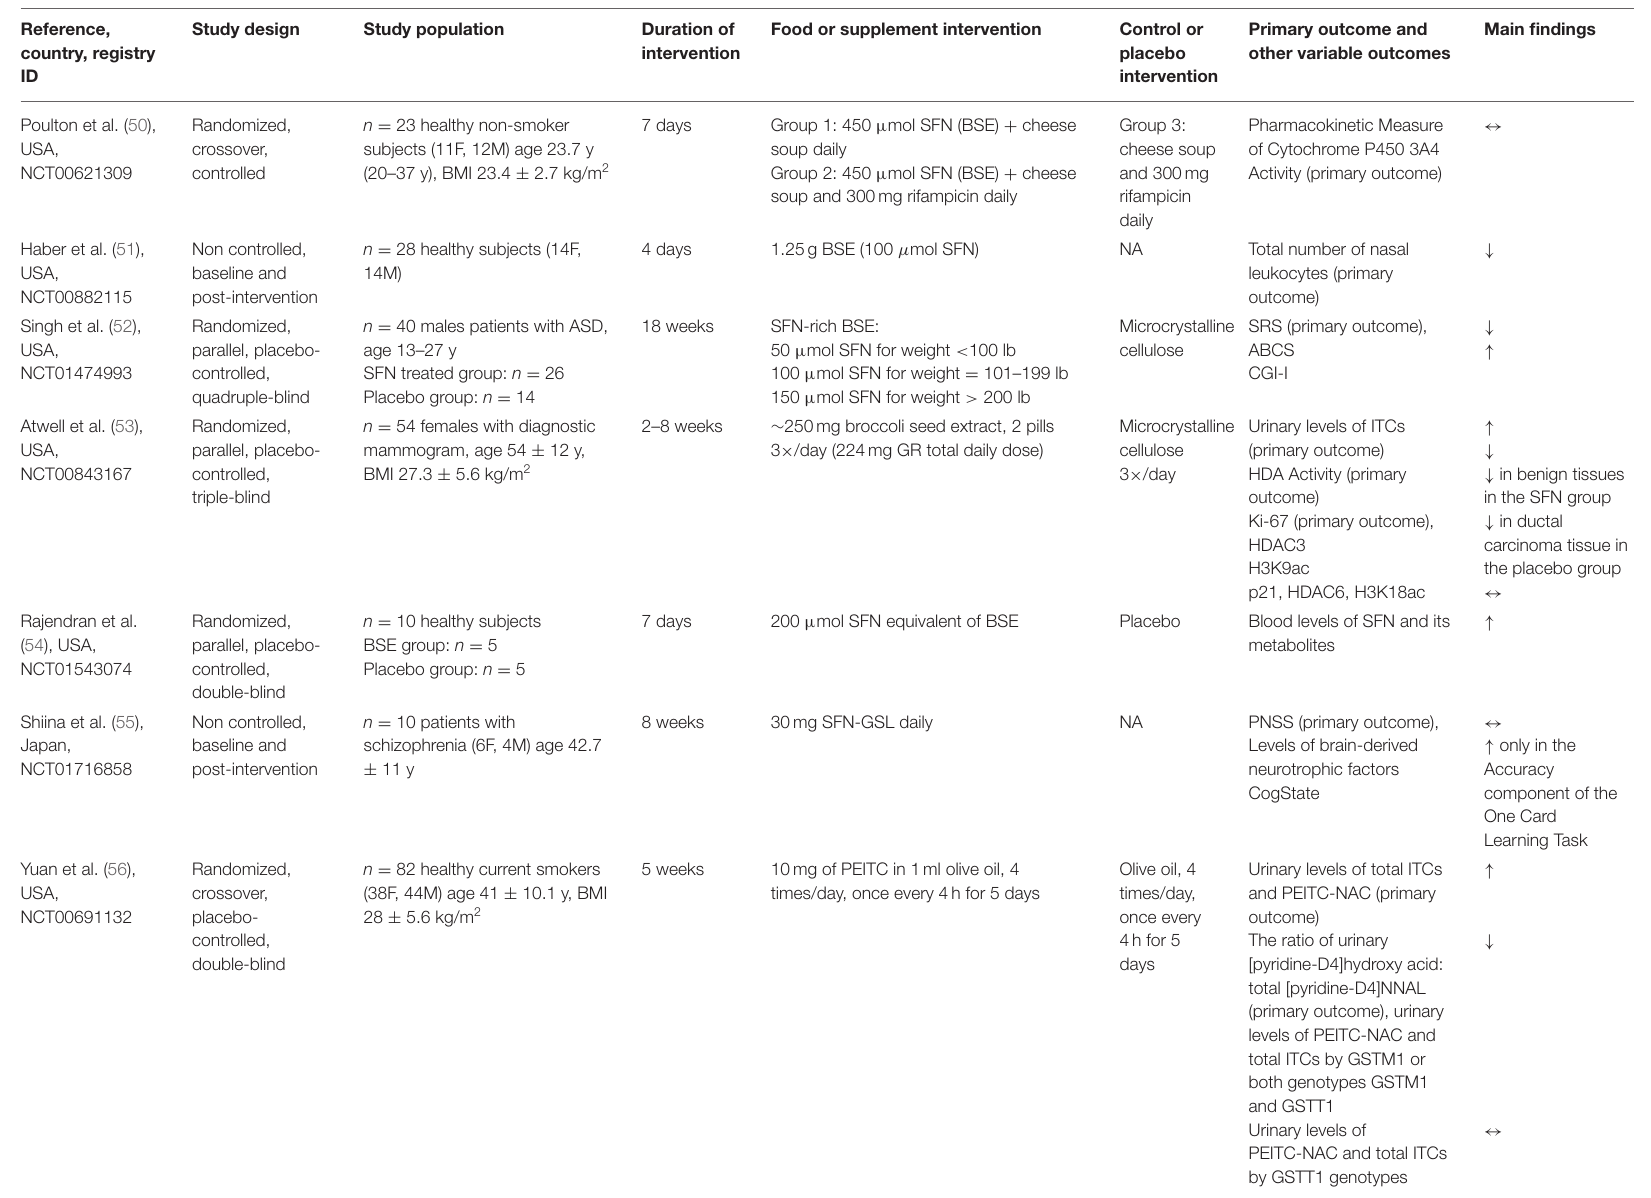
TABLE 4 | Characteristics and findings of publications associated with the registered trials on extracts or pure